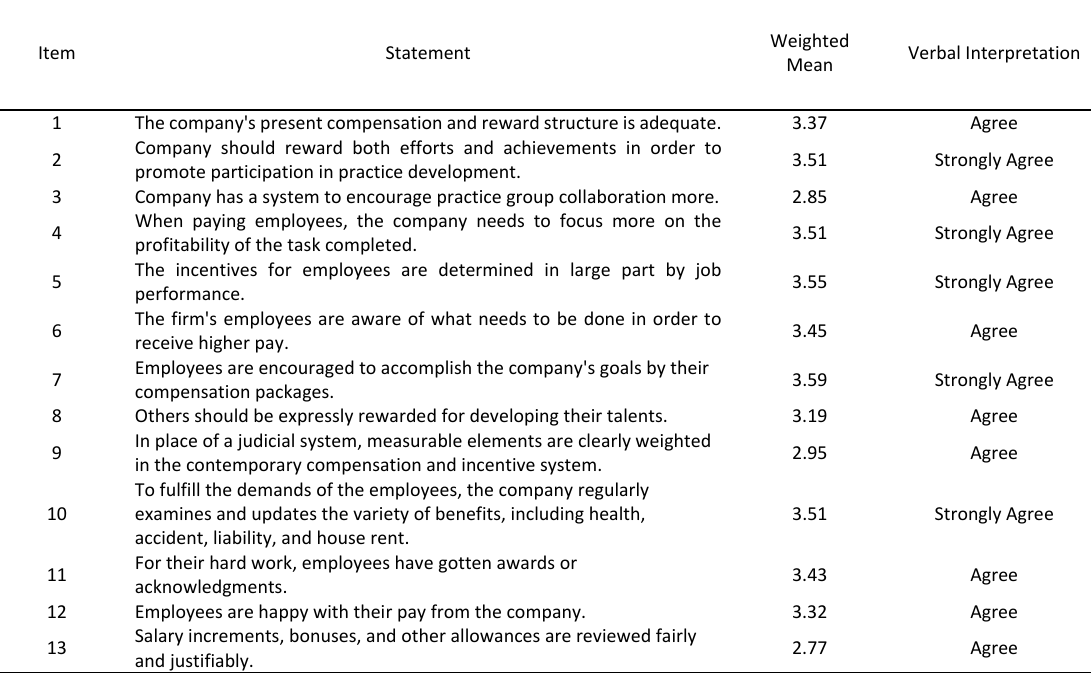
Table 9: Attitude of the respondents towards Rewards and compensation